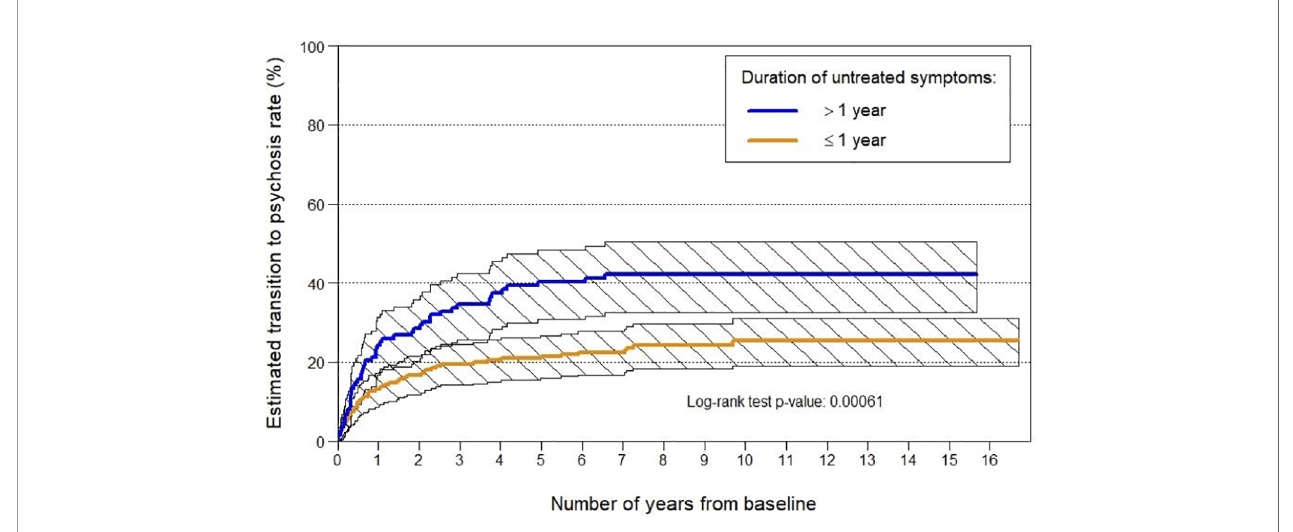
FIGURE 1 | Transition to psychosis rates by duration of symptoms prior to entry to Orygen ’ s ‘ ultra high risk ’ for psychosis